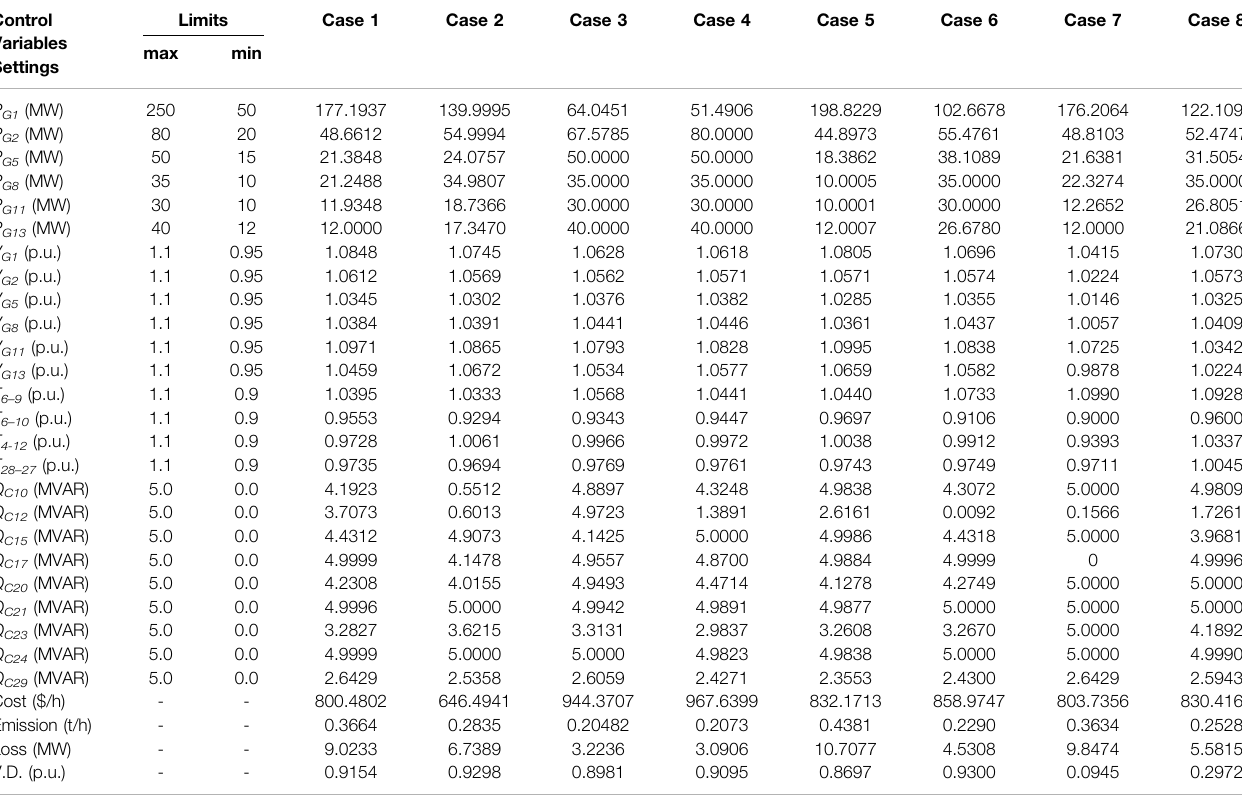
TABLE 1 | Optimal control variables of the proposed MGBLFA for determining the lowest cost (best solution) for various test scenarios. Control Variables Settings